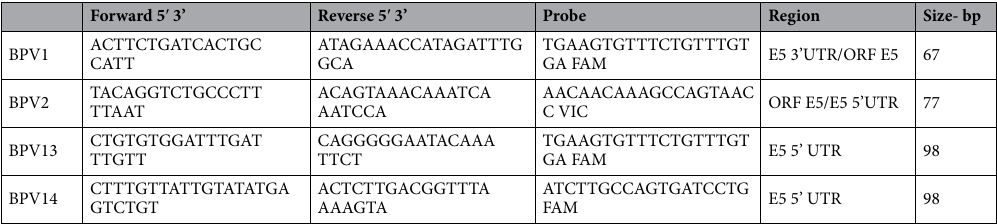
Table 1. Primers and probes used for detection of BPV-1, -2, -13, and -14 in ddPCR and